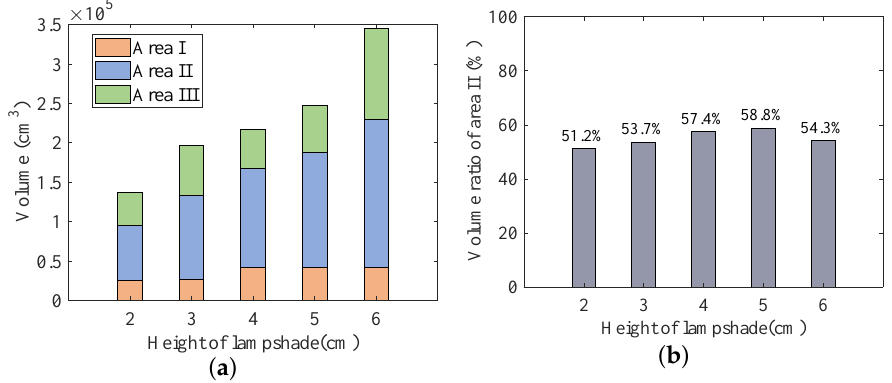
Figure 12. ( a ) Volume distribution of signal receivable area. ( b ) Volume ratio of area